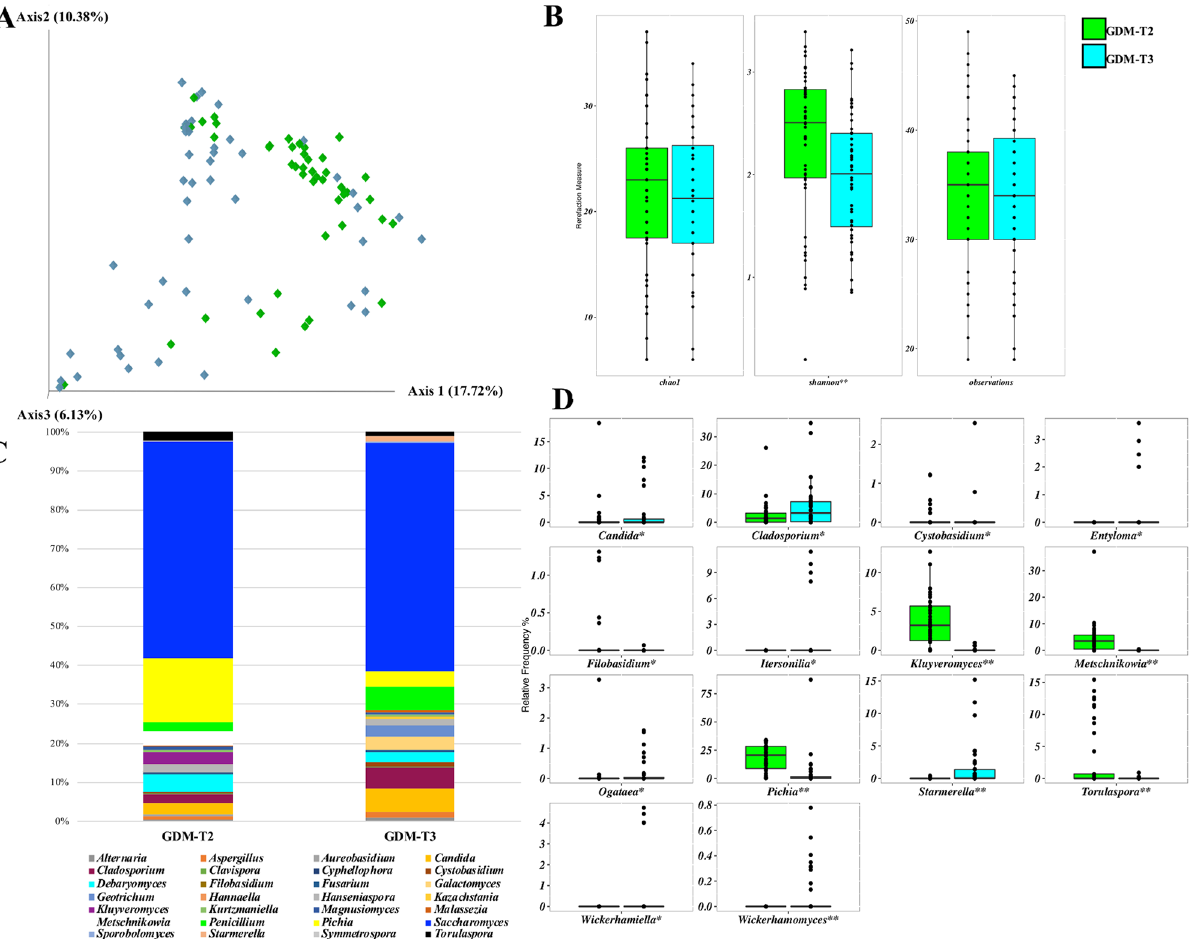
Figure 5. Beta ( A ) and alpha ( B ) diversity measures of the gut mycobiota of GDM patients at the second (T2) and third trimester (T3) of pregnancy. ( C ) global composition of mycobiota at genus level. Only ASVs with a relative frequency > 1% in at least 10 samples are shown. ( D ) boxplots of the ASVs at genus level which were significantly different within GDM women during the second (T2) and third (T3) trimester of pregnancy (Wilcoxon matched pairs test, * p < 0.05; ** p < 0.01).